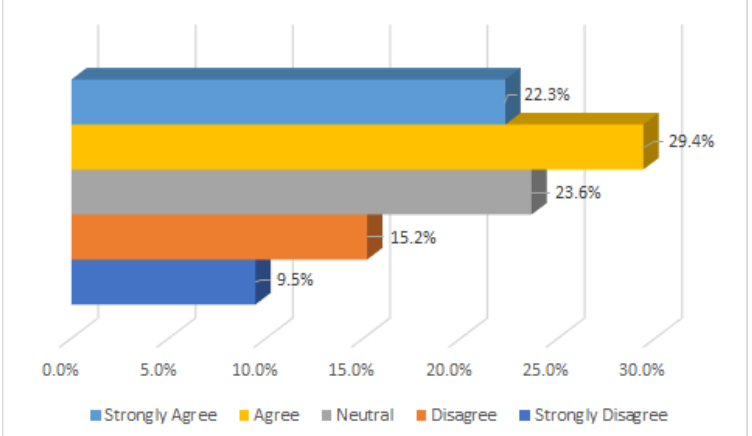
Figure 6. Answers to a Likert five-point scale to the question: Do you think team-working has helped to generate a positive-emotion